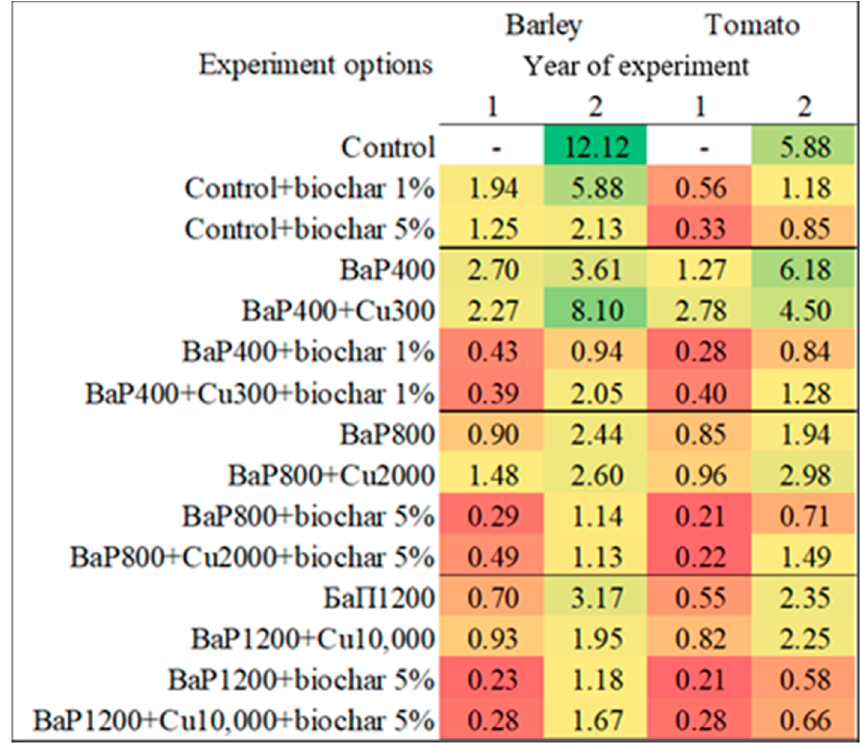
Figure 5. BaP half-degradation time (T50) in the Haplic Chernozem of model vegetation experiment; Figure years.